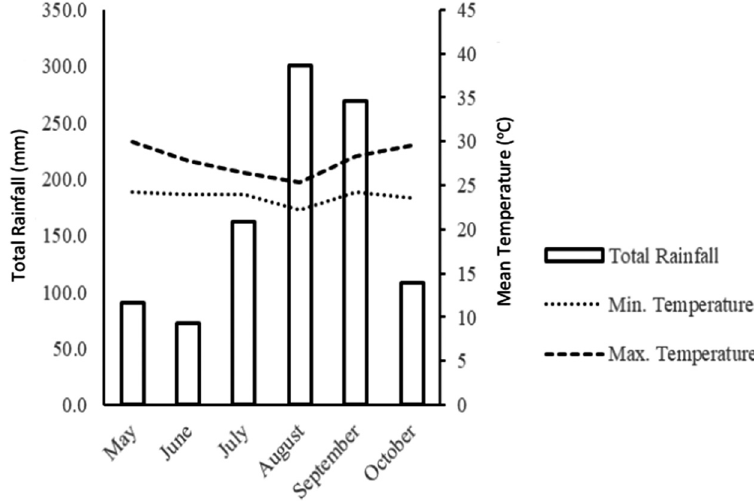
Figure 1: The monthly pattern of rainfall and temperature at the study site during the experiment ( 2017/2018 cropping season )